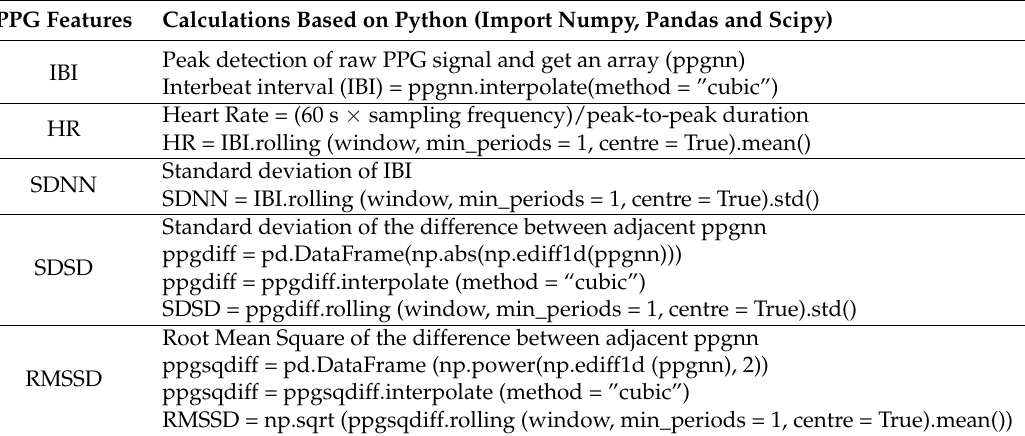
Table 1. Feature extraction from PPG, EDA and SKT